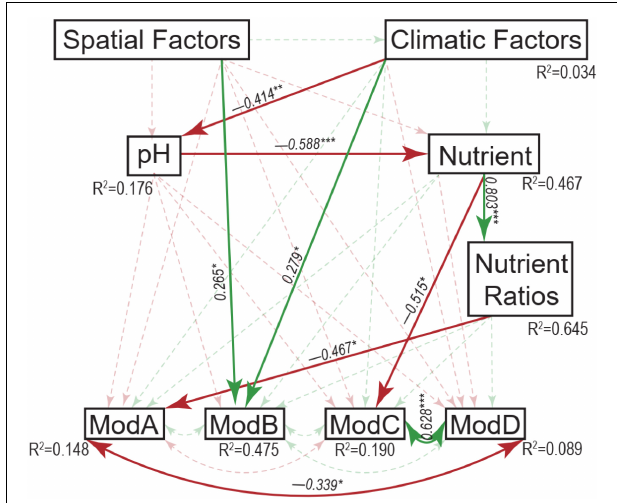
FIGURE 8 | Structural equation modeling analysis depicting the relationships between spatial factors (including latitude, longitude, and elevation), climatic factors (including mean annual temperature and mean annual precipitation), pH, nutrient (including sediment organic carbon, total nitrogen, and total phosphorus), nutrient ratios (including C:N, C:P, and N:P ratios), and the major modules (ModA, ModB, ModC, and ModD). Solid and dashed arrows represent the significant and non-significant relationships, respectively. Red and green arrows represent negative and positive relationships, respectively. The significant path coefficients were shown adjacent to the path with *, **, and *** denote the significant level of p < 0.05, p < 0.01, and p < 0.001,